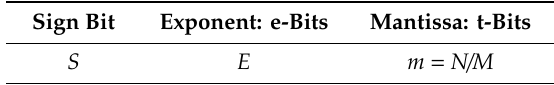
Table 1. Floating point (FLP) number